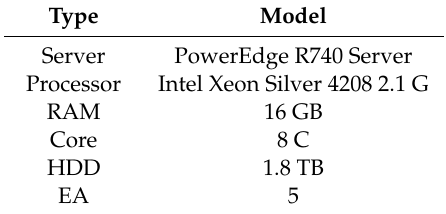
Figure 9. ( a ) Server; ( b ) test vehicle. Table 1. Server specifications.